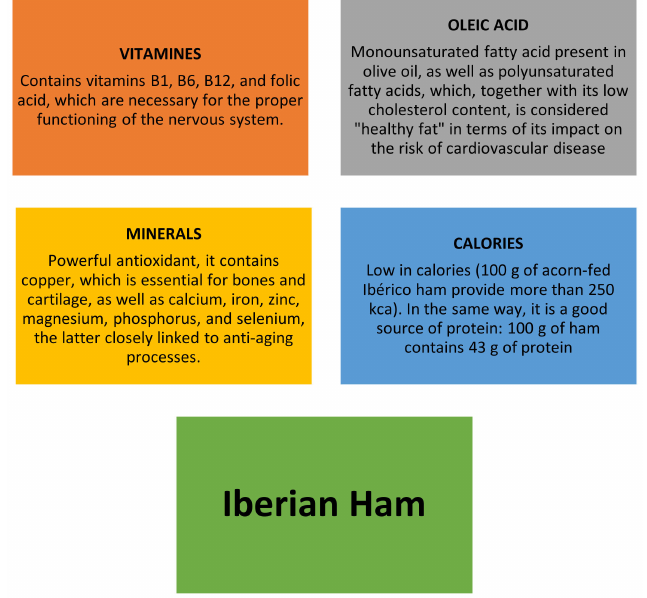
Figure 4. Benefits of Serrano ham. Source: own elaboration from Amaya-Corchuelo et al. [11] and P é rez et al.